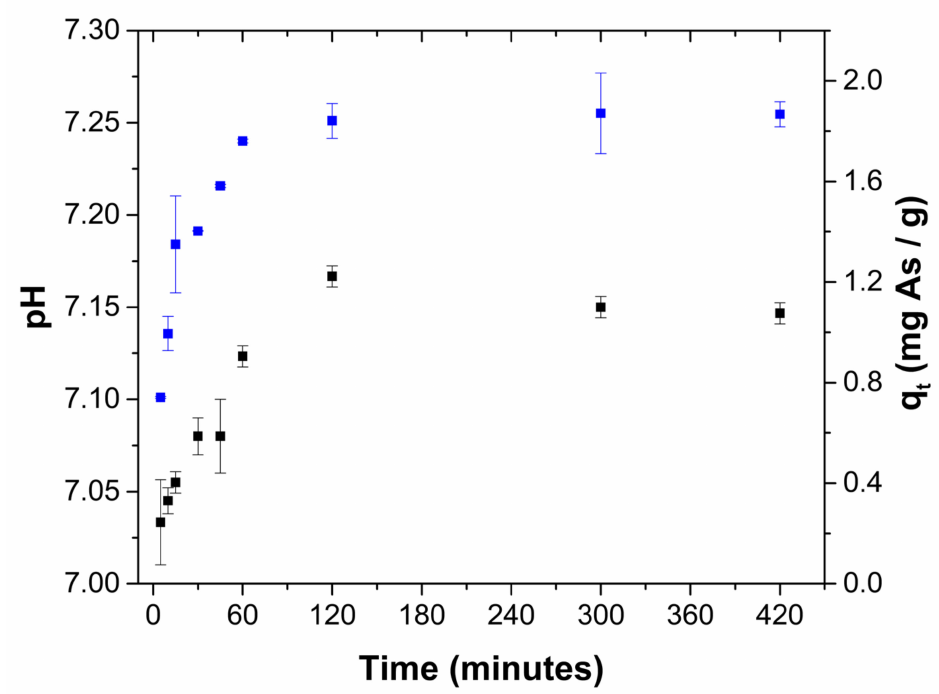
Figure 5. Uptake capacity ( (cid:4) ) and pH ( (cid:4) ) behavior as a function of contact time between ChM hydrogel beads and arsenate solution at an initial solution pH of 7.0 and an initial concentration of 15 mg